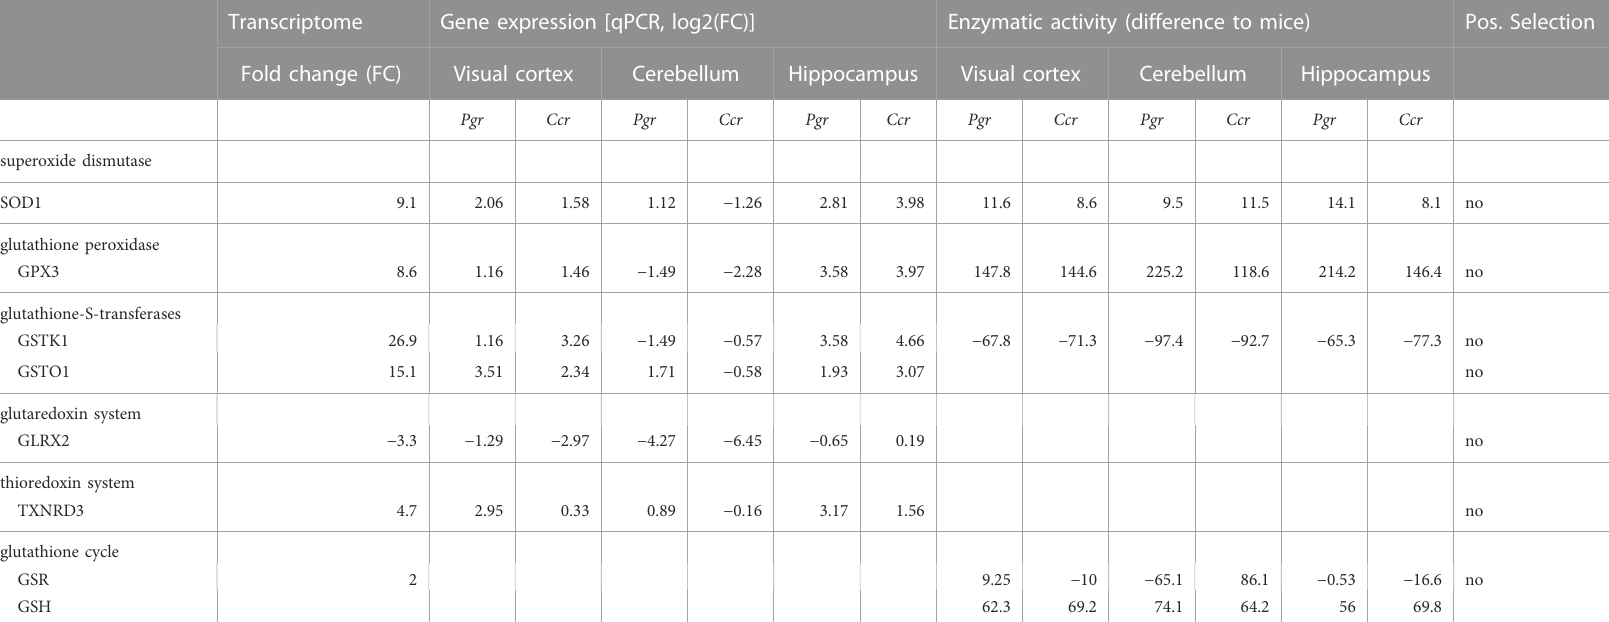
TABLE 2 Summary of results from the neuronal transcriptome of hooded seals andmice, the gene expression of harp seals (Pgr), hooded seals (Ccr) whole brain tissue normalized to aneuronal marker, as measured using qPCR, the enzymatic activity or concentration levels (for GSH), and the results from tests to infer positive selection. Fold changes (FC) and log2(FC) provide ameasure of the difference between pinnipeds and mice,whereby positive values indicate ahigher expression/activity/concentration inseals compared to mice.Enzymatic activity of SODwasmeasured inU/ml,GPX,GST,andGSR innmol/min/ml andGSH inµMand the difference is presented in the respective